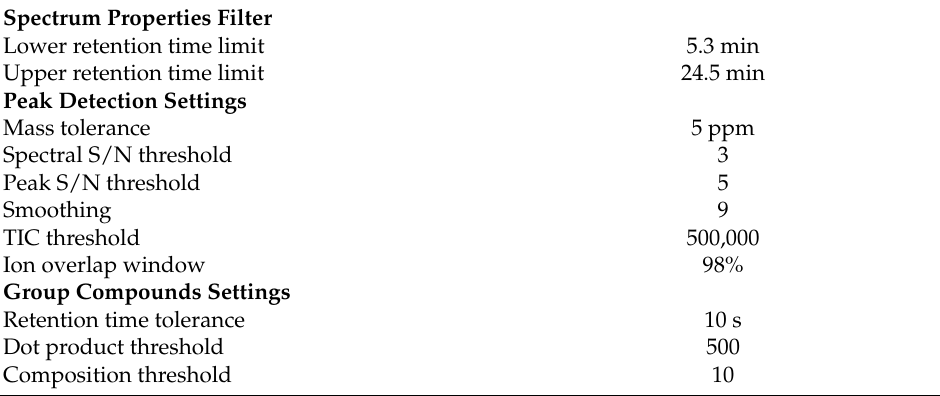
Table 4. Summary of processing parameters within the “Search Spectrum” and “GC EI deconvolution” node of the Compound Discoverer™ software (Version 3.2, Thermo Scientific, Bremen, Germany); S/N: signal-to-noise-ratio; TIC: total ion